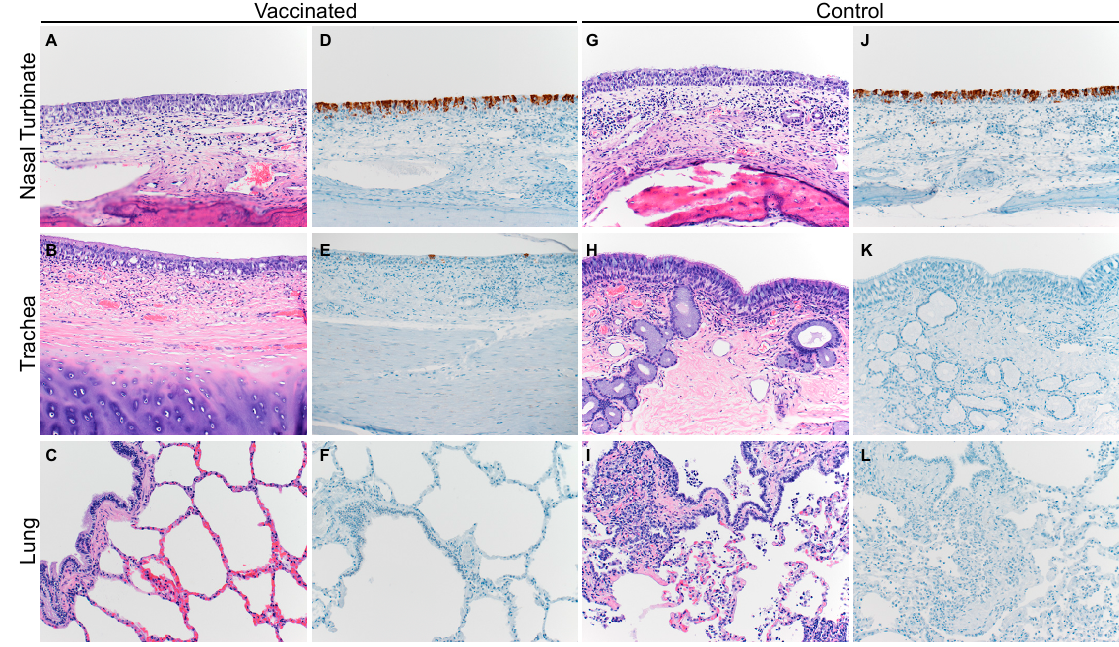
Figure 4. Histopathological changes in the respiratory tract of vaccinated and unvaccinated dromedary camels after challenge with MERS-CoV. Nasal turbinate, trachea, and lung were collected from vaccinated ( A – F ; CA3 shown) and unvaccinated control animals ( G – L ; CA5 shown) on 5 dpi and stained with hematoxylin and eosin ( A – C and G – I ), or a polyclonal anti-MERS-CoV antibody ( D – F and J – L ). MERS-CoV antigen is visible as a red brown staining in the immunohistochemistry panel. Vaccinated and unvaccinated camel groups displayed multifocal, minimal-to-mild, acute rhinitis. MERS-CoV antigen was primarily detected in the nasal turbinates. Magnification: 400×.